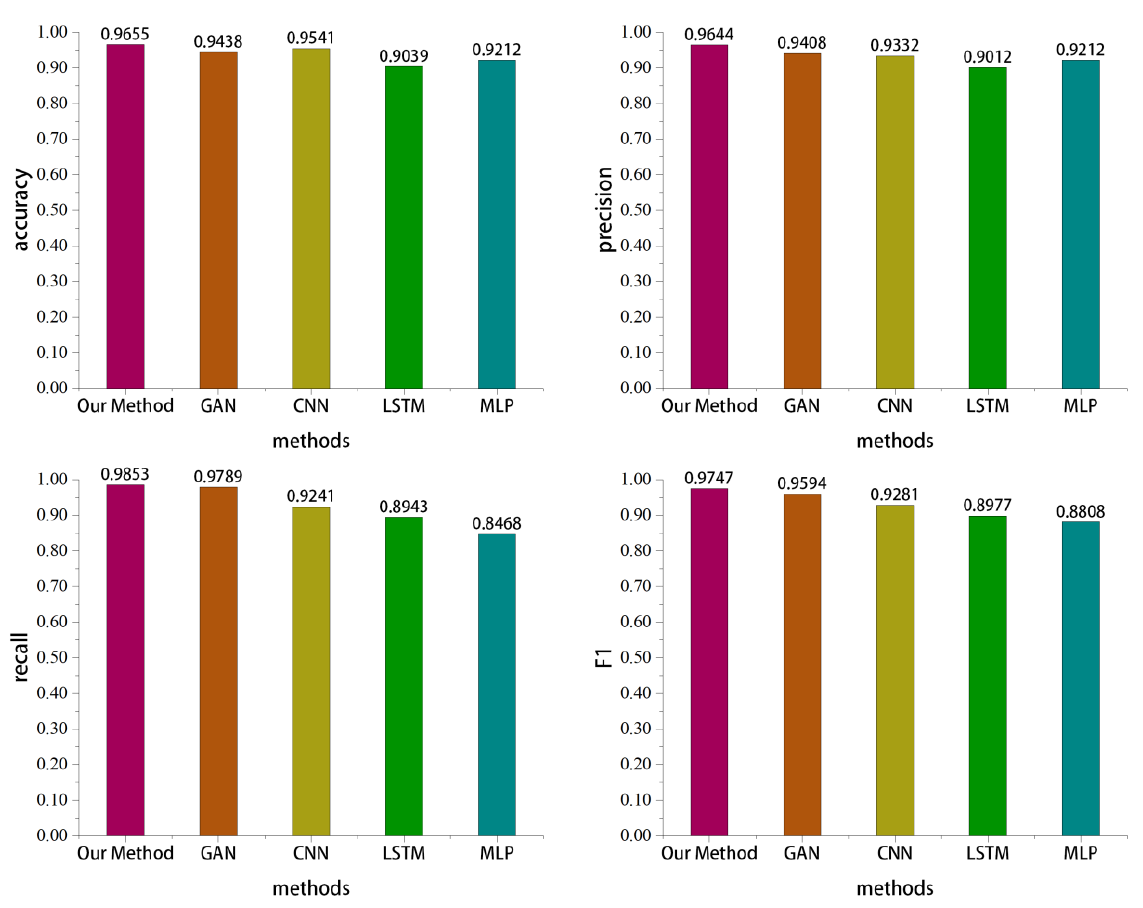
Table 1. Comparison outcomes on our method, DBN + LSTM, and LSTM.